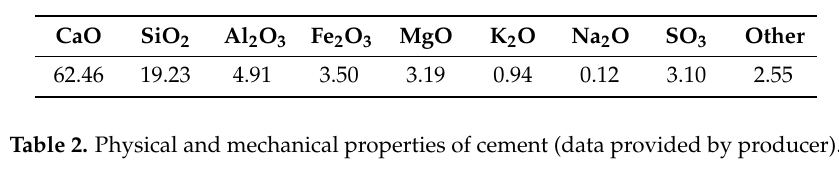
Table 1. Chemical composition of cement, %.